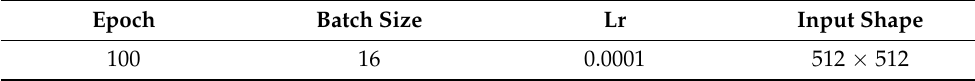
Table 3. Optimal hyperparameters.